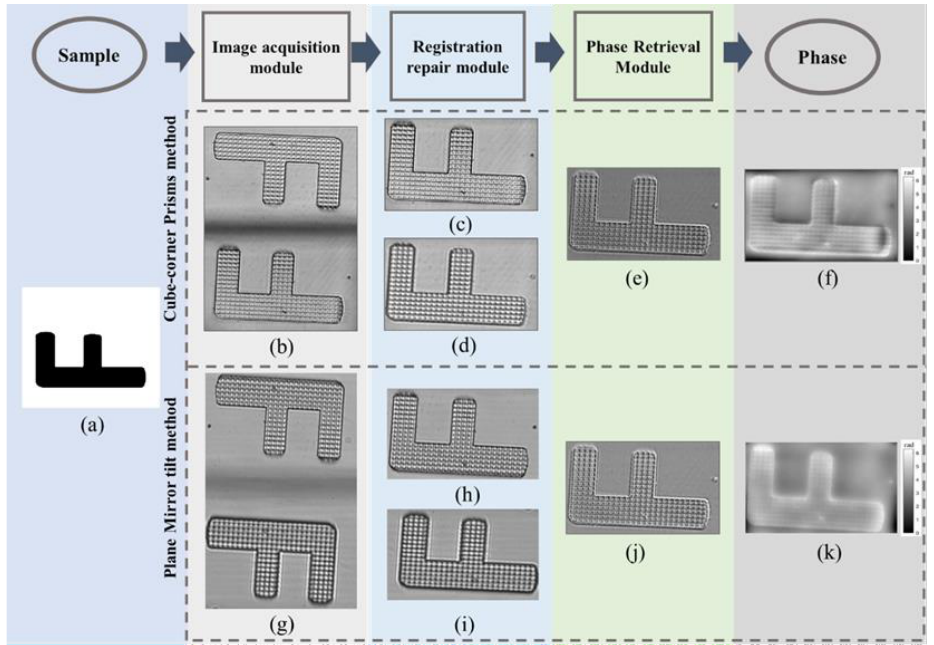
Figure 7. Experimental process and retrieval results of lithography samples. ( a ) Sample; ( b – f ) The experimental process and results of the cube-corner method (registered repair); ( g – k ) The experimental process and results of the plane mirror tilt method (registered repair)